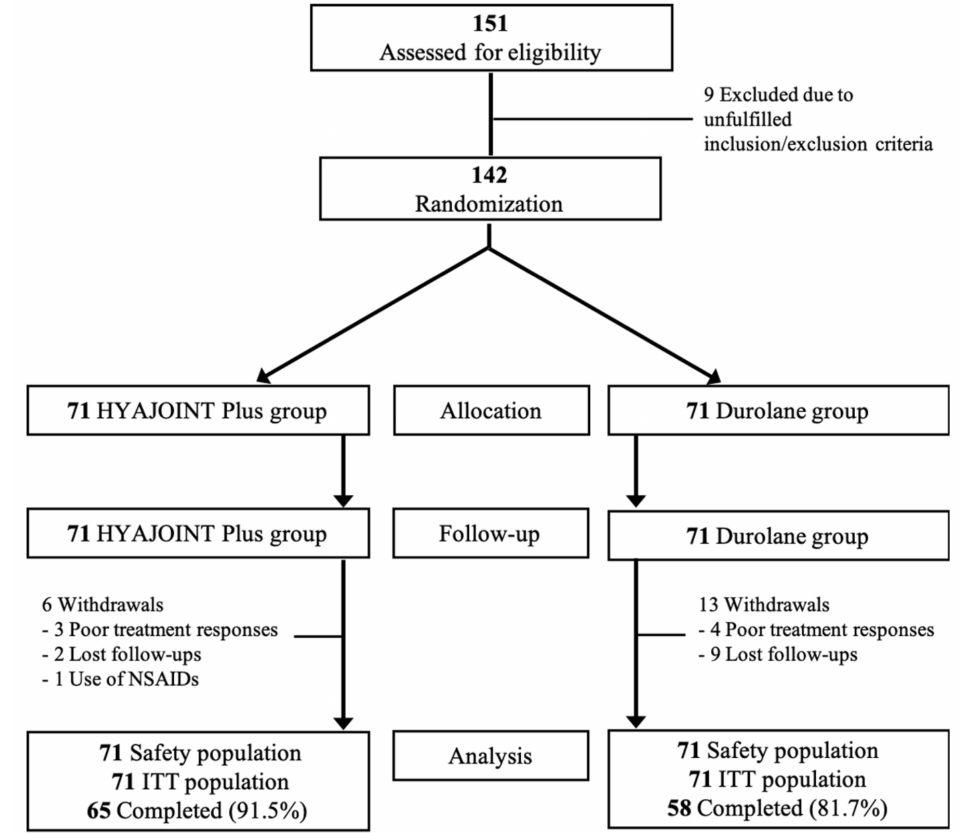
Figure 1. Flow diagram of the randomized controlled